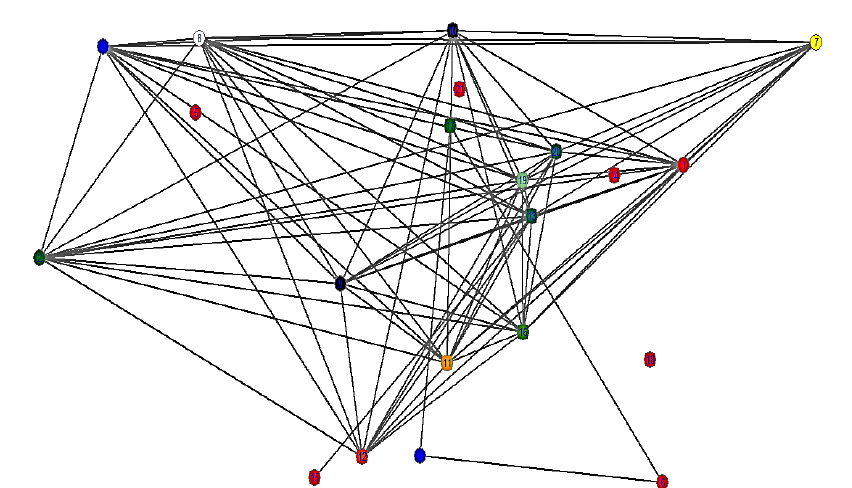
Figure 4. Selecting contours or cycles that can be created by banks